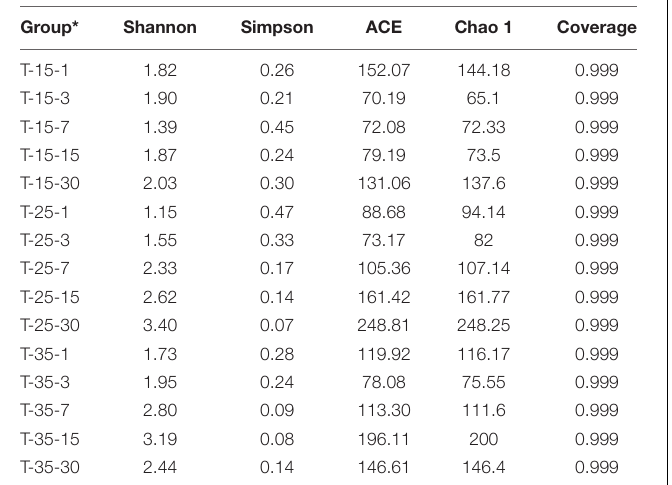
TABLE 3 | Variation of α diversity indexes under different temperatures.